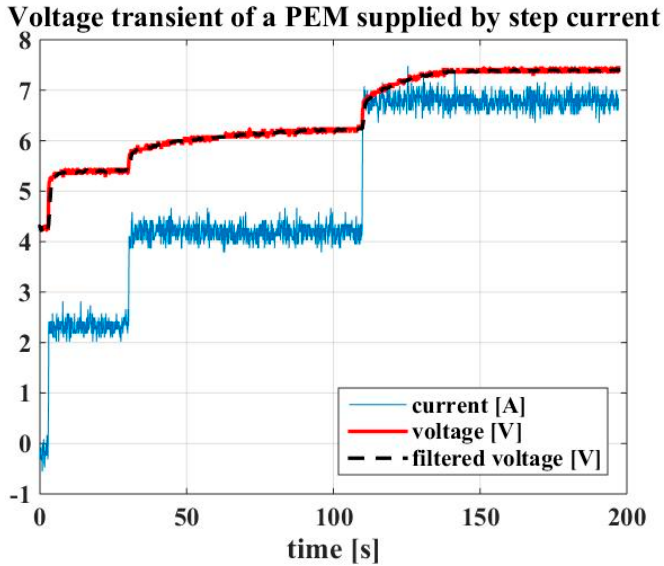
Figure 6. Example of voltage transient.